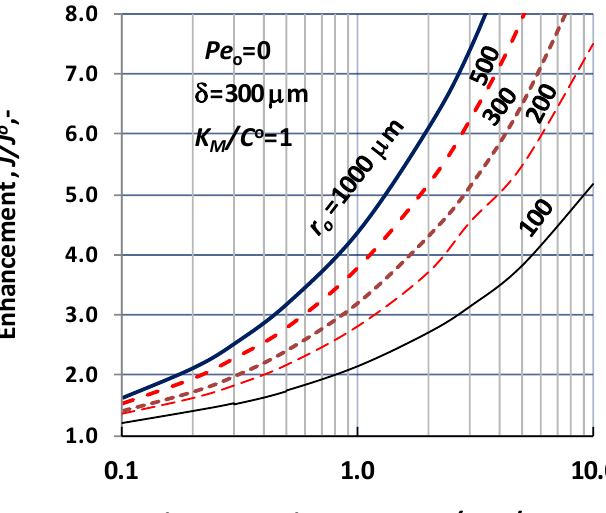
Figure 7. Enhancement as a function of the bioreaction rate, i.e., v max / C O , at di ff erent values of the lumen radius, applying sweeping phase on the permeate side of the biocatalytic membrane reactor, d C / d R > 0 at R = R m ( N = 1000; δ = 300 µ m; K M / C O = 1; D = 1.9 × 10 − 9 m 2 /